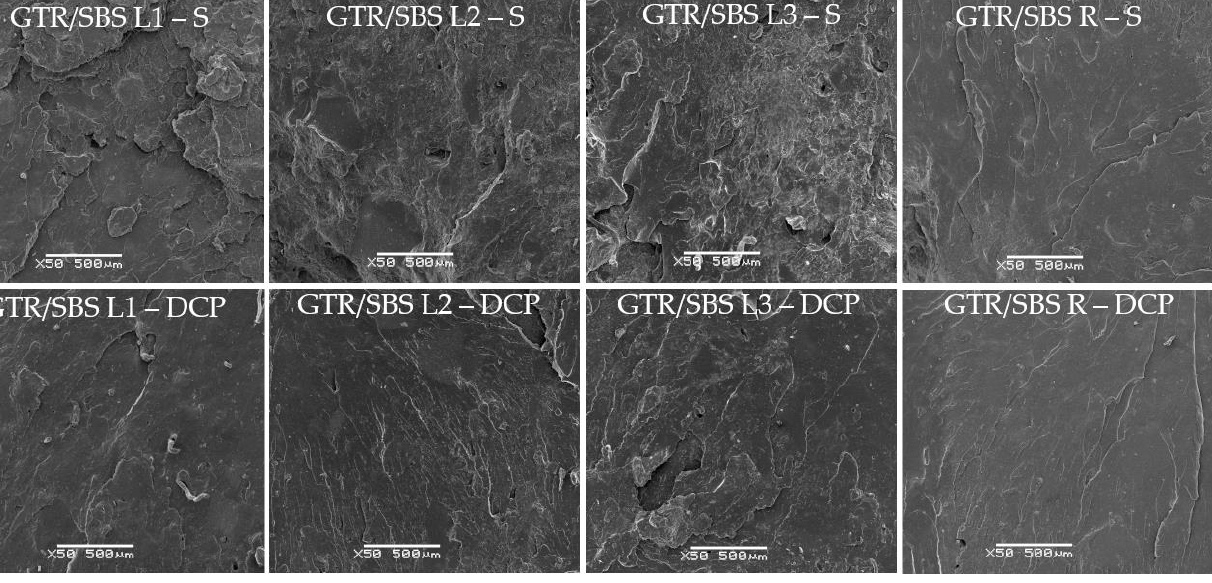
Figure 5. SEM images of GTR/SBS blends as function of SBS grade and curing system (magnification ×50).